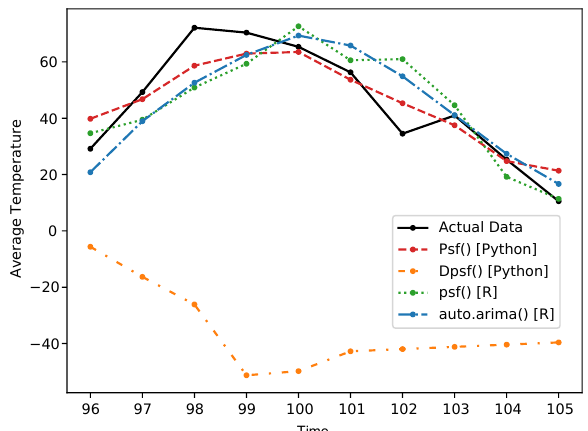
Figure 17. Plot showing the test data and values forecasted using various methods for the “Average Temperature”